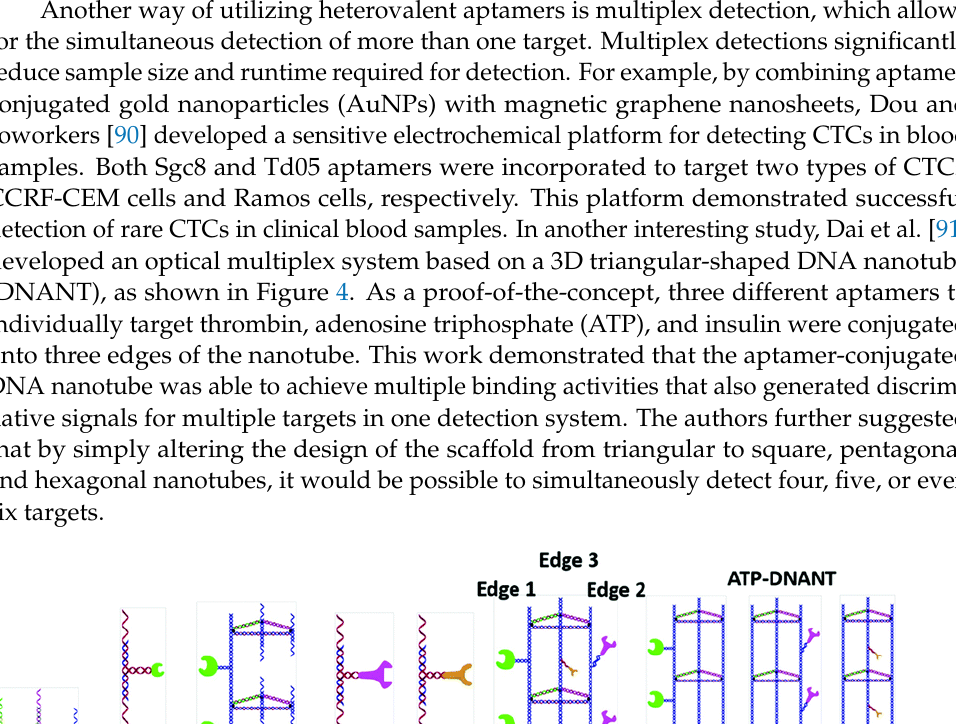
Figure 3. Schematic description of aptamer-cocktail-based microfluidic approach for CTC detection.